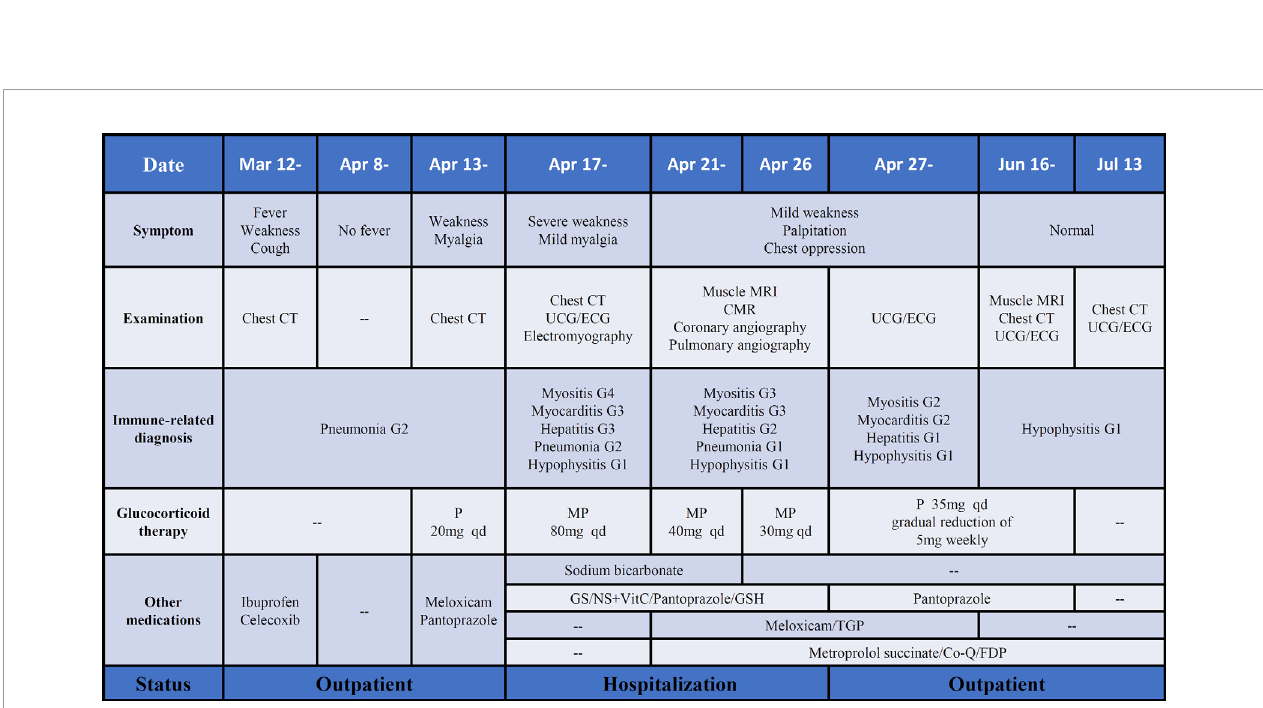
FIGURE 4 | The process of diagnosis and treatment of irAEs after ICI therapy. P, prednisone; MP, methylprednisolone; GS, glucose solution; NS, normal saline; TGP, total glucosides of paeonia; Co-Q, coenzyme Q; FDP, fructose1, 6-diphosphate. Note: The grade of irAEs refer to the management of immunotherapy-related toxicities from the NCCN clinical practice guidelines and the consensus recommendations from the Society for Immunotherapy of Cancer (SITC) Toxicity Management Working Group.